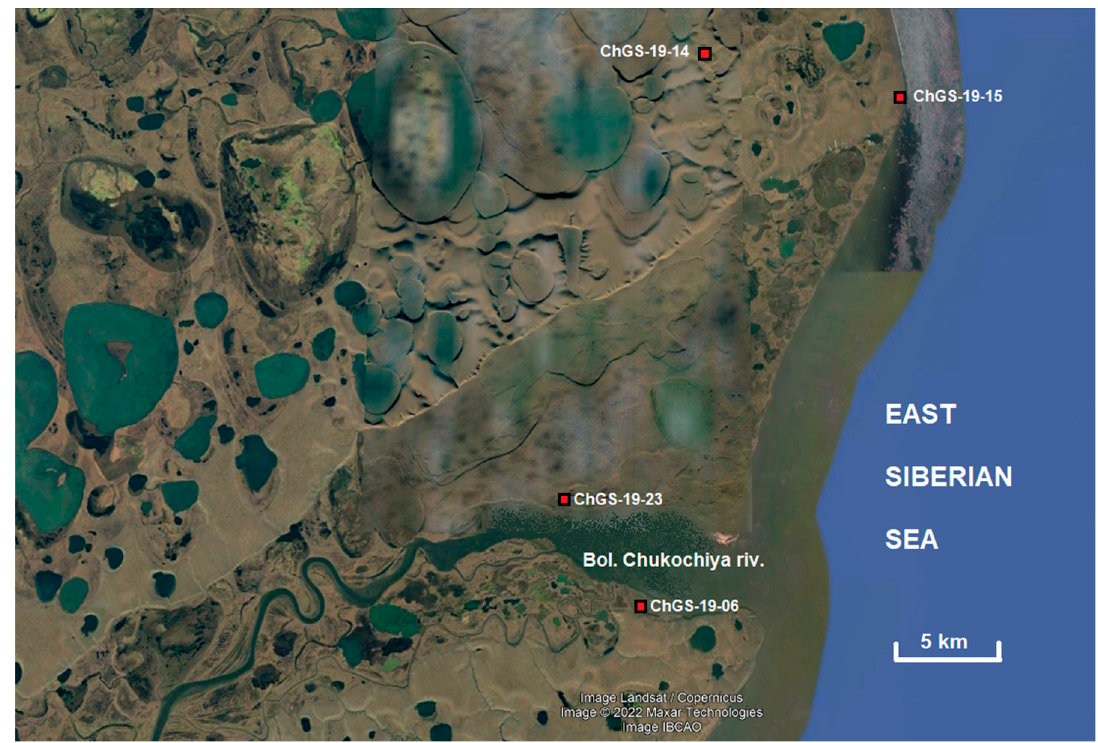
Figure 1. Watt (ChGS-19-06), marsh (ChGS-19-23), maritime soils (ChGS-19-14) and allochtonous deposits sampling point (ChGS-19-15) of the studied area.